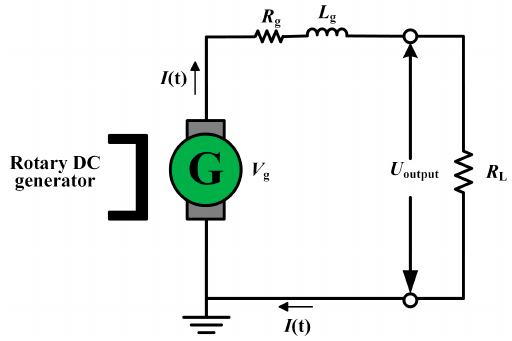
Figure 2. The equivalent circuit model for a rotary DC generator.